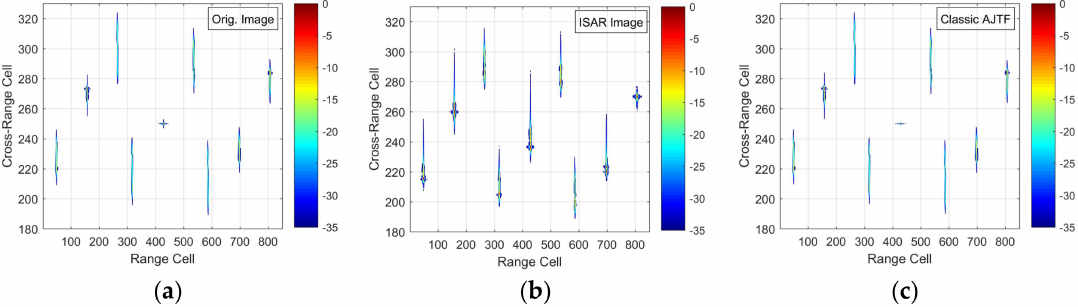
Figure 4. Imaging results using classical methods. ( a ) Direct imaging; ( b ) classical ISAR; and ( c ) classical AJTF.